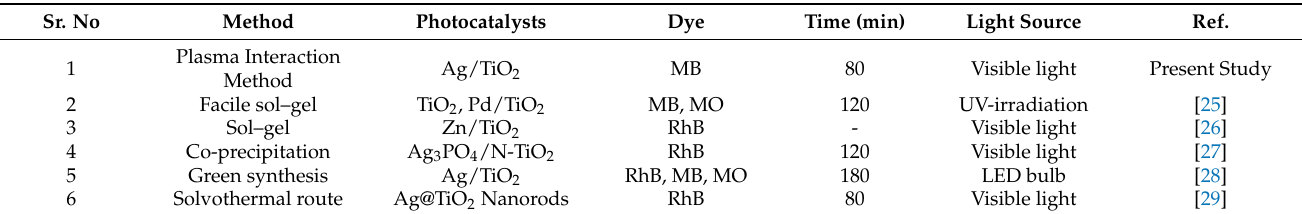
Table 4. A comparison of photocatalytic activity of LPI synthesized Ag/TiO 2 composite with previous studies. Sr.